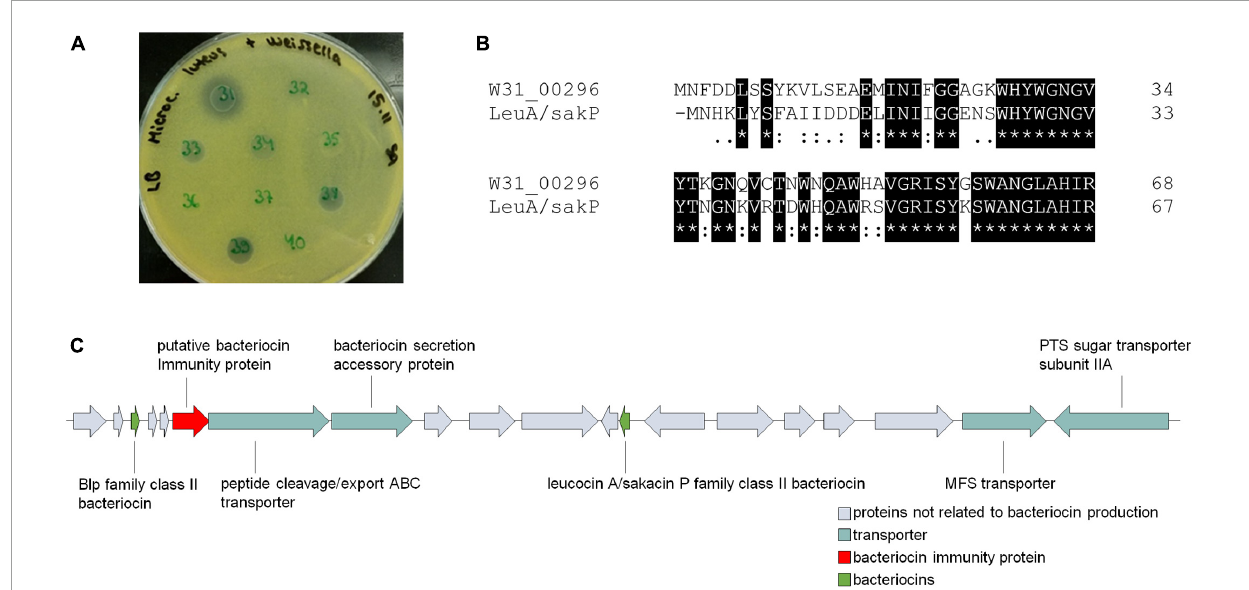
FIGURE5 Bacteriocin production potential of Weissella paramesenteroides. (A) Bactericidal activity of ten Weissella idli isolates, showing the inhibitory activity of W. paramesenteroides strain W31 against M. luteus . Spot number 32 is W. paramesenteroides strain B1. (B) Amino acid sequence alignment between the gene product Gp00296 from W31 (W31_00296) and the putative leucocin A/sakacin P family class II bacteriocin (LeuA/SakP) identified in DmW_118 and DmW_118119. (C) Genomic area including genes for putative bacteriocin production in DmW_118 and